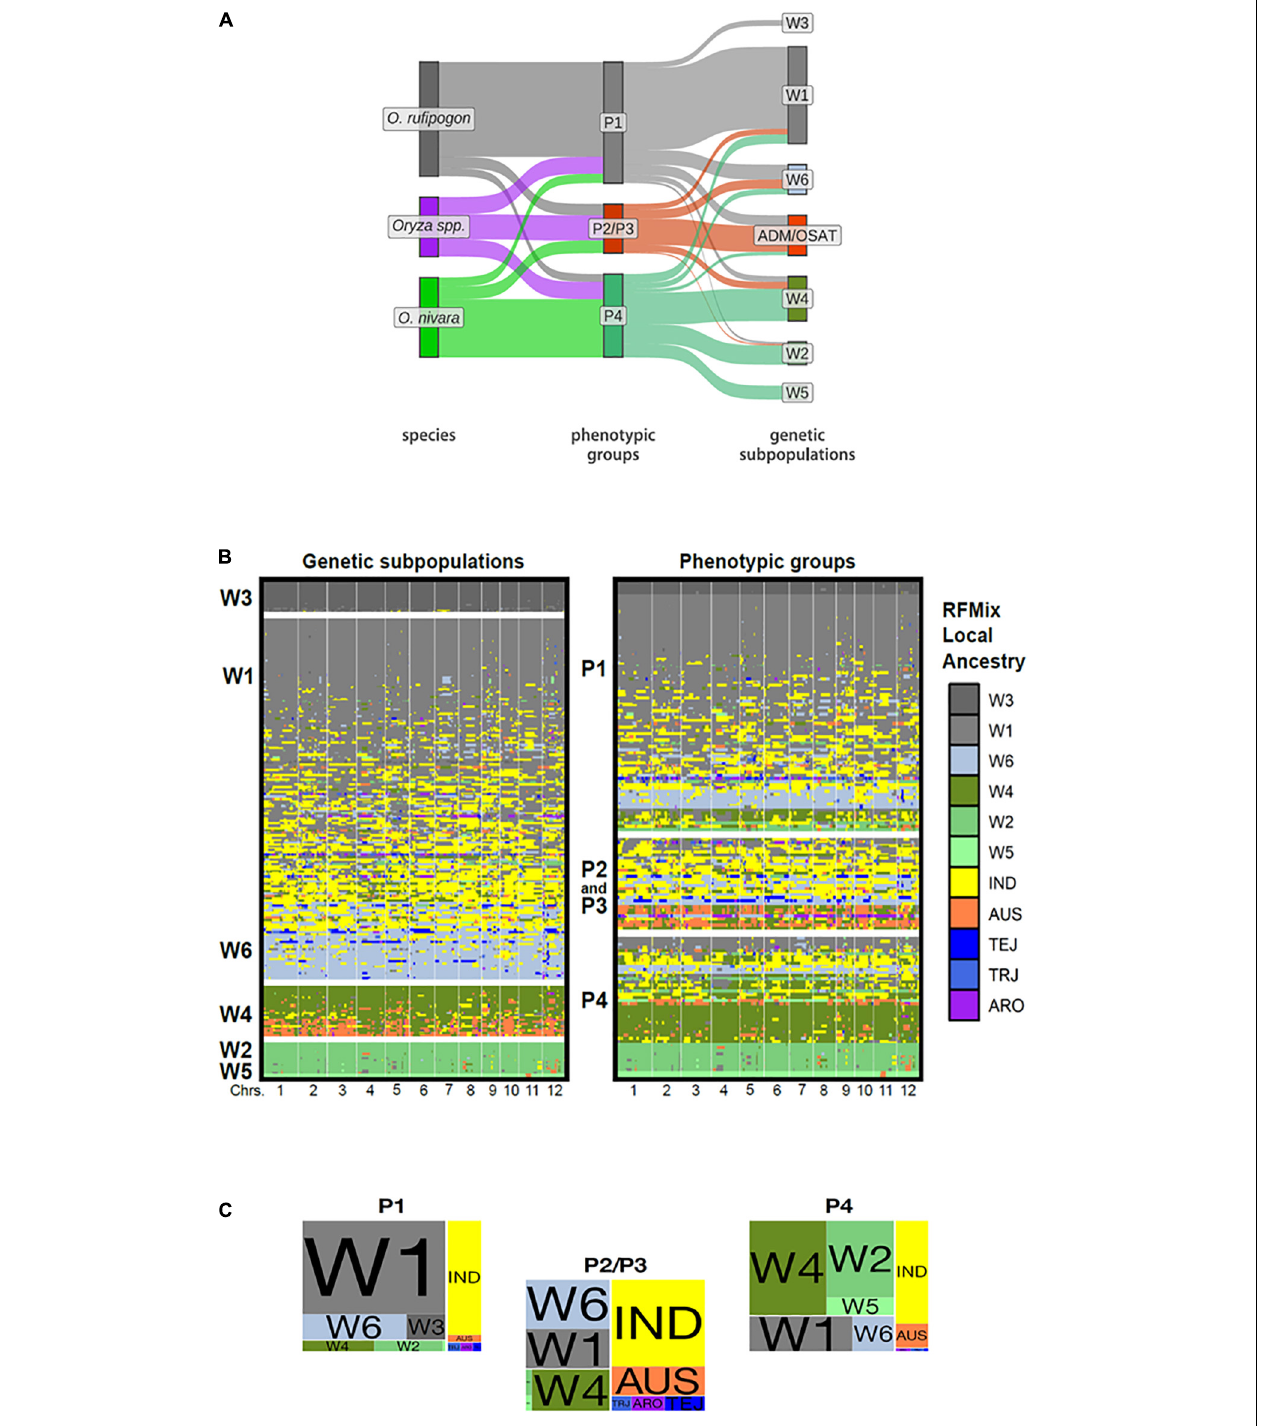
FIGURE 3 | Genotypic composition, local ancestry and phenotypic groups of ORSC accessions. (A) Sankey plot depicting correspondence between traditional species designations, our phenotypic groups, and Kim et al. (2016) genetic subpopulations using 32 phenotypic traits. (ADM/OSAT are accessions with a high proportion of admixture with O. sativa ) (B) Graphical genotypes display the local ancestry of each ORSC individual as determined by RFMix trained on six ORSC subpopulations (W1-W6) and five O. sativa subpopulations: indica (IND), aus , (AUS), temperate japonica (TEJ), tropical japonica (TRJ), and aromatic (ARO). The accessions are arranged according to global genotypic ancestry (left) and phenotypic group assignment (right). Each individual’s genotype is represented by two adjoining rows corresponding to phased haplotypes with colors indicating RFMix population assignments of chromosome segments (C) Proportion of the ORSC subpopulations (left) and O. sativa subpopulations (right) within each of the three phenotypic classes.